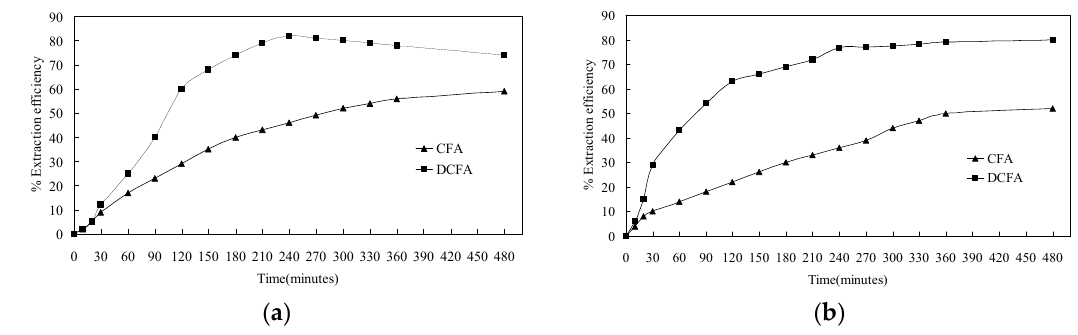
Figure 11. Extraction efficiency of CFA and DCFA under optimum conditions, ( a ) lithium extraction; ( b ) aluminum extraction (6 mol/L, 120 °C, S/L ratio of 1/20, 4 h). Table 4. Chemical compositions of CFA, DCFA, and the residues (mass fraction, wt %).